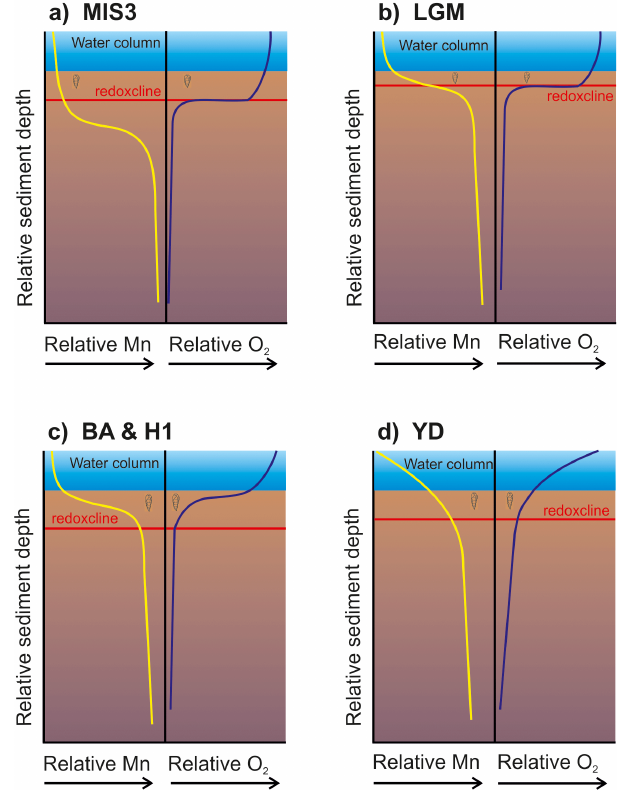
Figure 5. Idealised schematic pore-water Mn (yellow) and oxy- gen (blue) profiles for the climatic intervals studied from the GeoB7926-2 record. The red line represents the redoxcline. (a) MIS3: low foraminiferal Mn / Ca, and therefore the sedimentary Mn was precipitating below the living depth of E. exilis and more- oxygenated conditions prevailed in the bottom and pore waters. (b) LGM: foraminiferal Mn / Ca increases, and therefore a relative de- crease in pore-water oxygen is apparent and the redoxcline is shal- lower. (c) BA & H1: foraminiferal Mn / Ca increases further, and the moderate–low sedimentary Mn / Al indicates low bottom-water conditions. (d) YD: highest accumulation of Mn and therefore oxy- gen deficiency in the bottom and pore